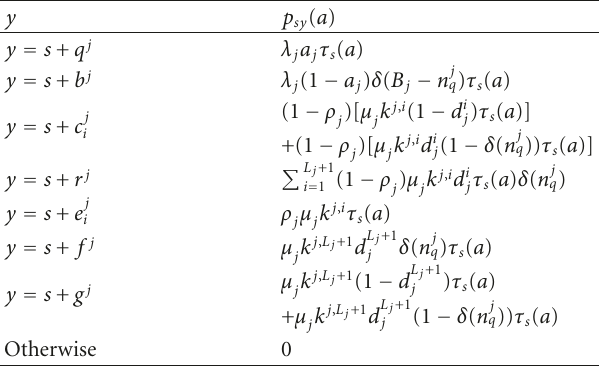
Table 4: Representation of vectors in Table 2: each defined vector represents a possible state transition from current state s